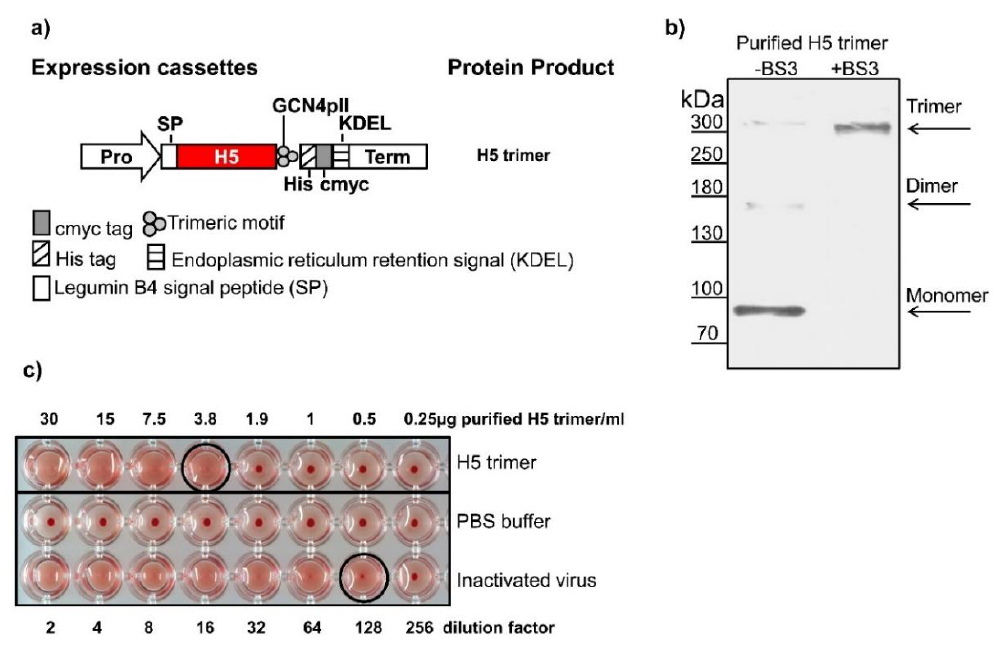
Figure 1. Expression and characterization of plant-derived H5 trimers. ( a ) Plant expression cassette. The ectodomain of hemagglutinin was C-terminally fused to the GCN4pII motif for trimerization, a c-Myc tag for downstream detection by Western blotting and a His tag for purification by IMAC. The legumin B4 signal peptide (SP) and the KDEL motif caused ER retention [17]. Pro: cauliflower mosaic virus 35S ubiquitous promoter; term: cauliflower mosaic virus 35S terminator. ( b ) Oligomeric state of the H5 trimer confirmed by a crosslinking reaction. Purified H5 proteins were supplemented with the BS3 crosslinker at 5 mM or left untreated and visualized by Western blotting with an anti-c-Myc monoclonal antibody. ( c ) Functional characterization of purified H5 trimers by the hemagglutination assay. Two-fold serial dilutions of purified H5 trimers were mixed with the given amounts of chicken red blood cells, and hemagglutination was recorded. Circles indicate hemagglutination